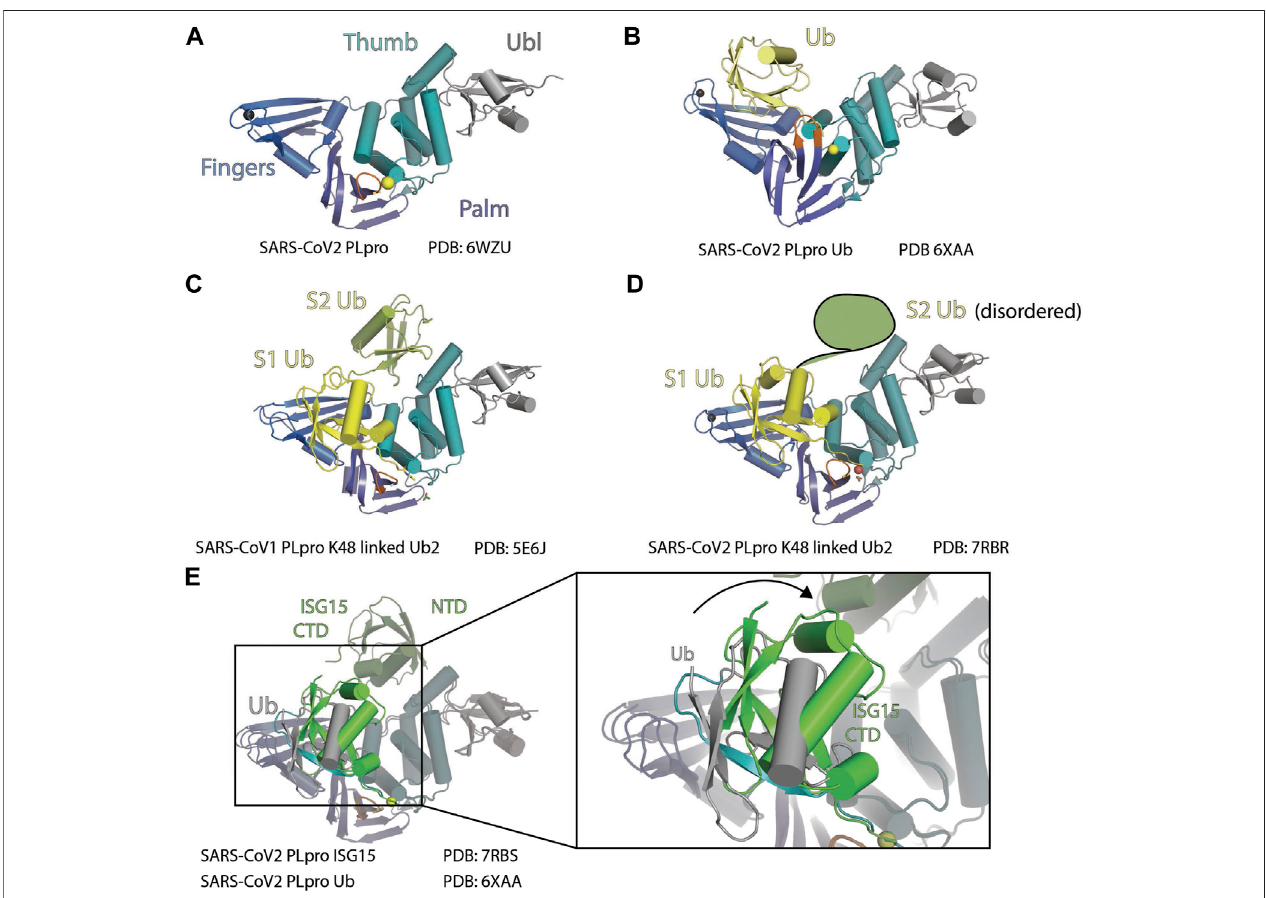
FIGURE2| Structure ofPLprowithUbl. (A) Crystalstructure ofSARS-CoV-2PLproisshownascartoontodemonstrate itsfourdomains(PDB:6WZU):Ubiquitin- like domain Ubl (gray),Thumb domain (teal), Palm domain (slate), and Finger domain (marine). BL loopiscoloredorange. Sulfur atomofC111 and Zinc ionare shown as spheres. (B) Crystal structure of SARS-CoV-2 PLpro in complex with ubiquitin is shown as cartoon (PDB 6XAA). PLpro is colored as in panel A and ubiquitin is colored yellow. (C) Crystal structure of SARS-CoV-1 PLpro in complex with K48-linked diUb is shown as cartoon (PDB 5E6J). S1 (proximal) Ub is colored yellow, and S2 (distal) Ub is colored lime. (D) Crystal structure of SARS-CoV-2 PLpro in complex with K48-linked diUb is shown as cartoon (PDB: 7RBR). S1 Ub is colored yellow. S2 (distal)Ubisdisordered,anditspositionisoutlined. (E) CrystalstructureofSARS-CoV-2withUb(PDB:6XAA)issuperimposedwiththecrystalstructureofSARS-CoV-2 with ISG15 (PDB: 7RBS). The rotation of ISG15 CTD compared to Ub at S1 site is highlighted.